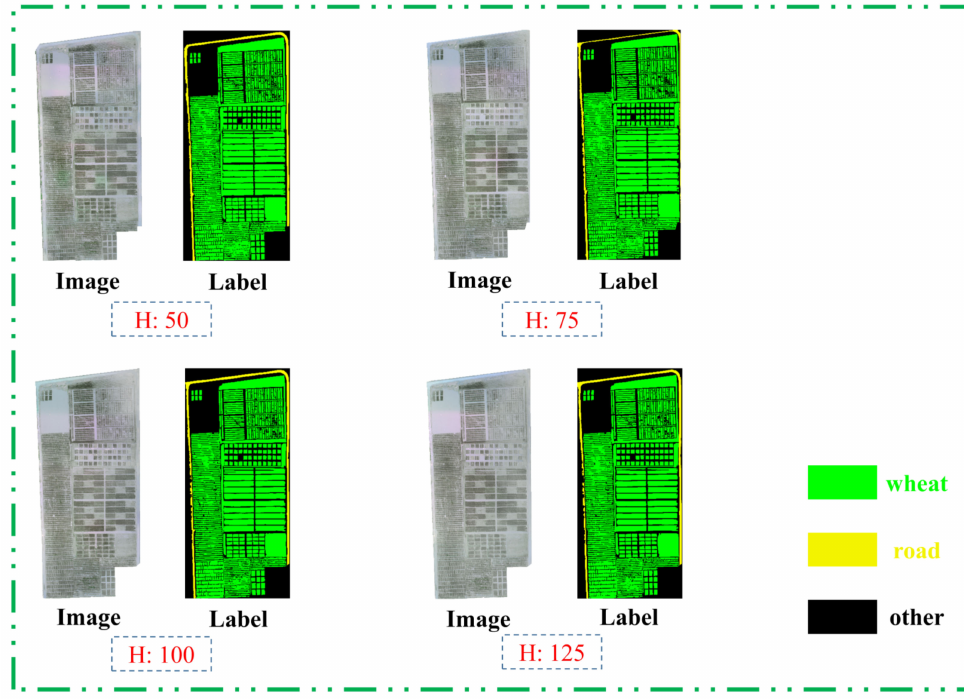
Figure 8. Multispectral remote sensing images and their